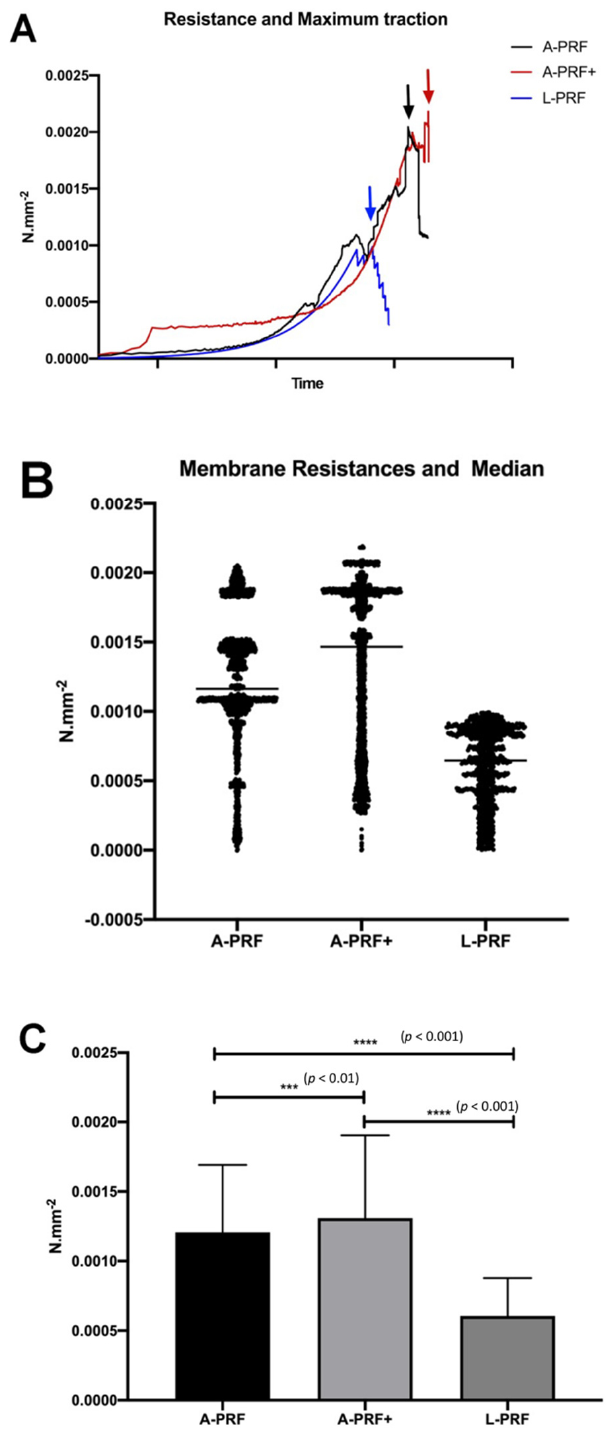
Figure 4. ( A ) Resistance and maximum traction where A-PRF+ reaches a higher strength value compared with A-PRF and L-PRF tested. ( B ) Average and standard deviation (SD) comparing all groups analyzed. ( C ) Membrane resistance and median show the variability of results felt mainly in the L-PRF group and more consistently in